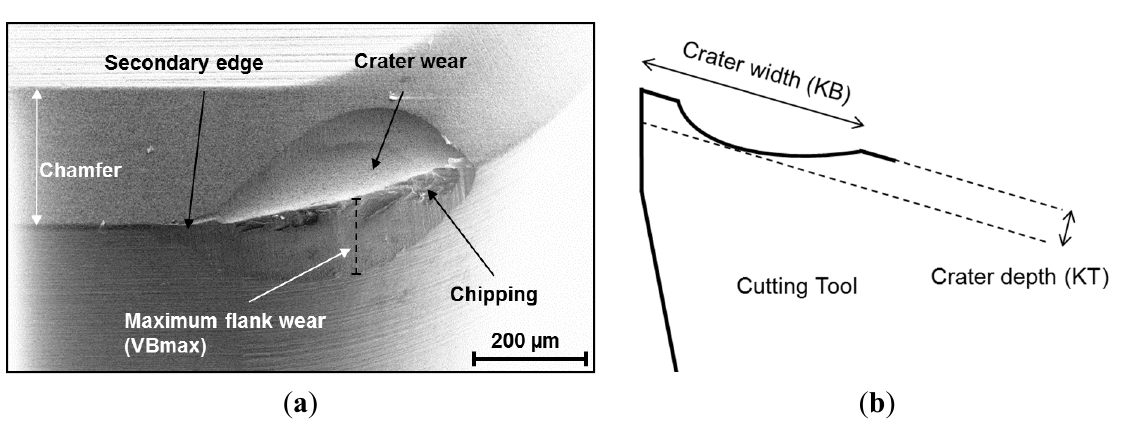
Figure 8. ( a ) Examples of tool wear patterns after turning of a hardened steel using a poly-crystalline boron nitride (PCBN) cutting tool; and ( b ) How to measure the crater depth (KT) and crater width (KB)